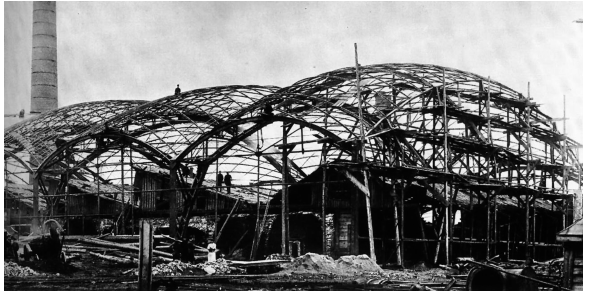
Figure 5: Production Hall in Vyksa, Rusia by V. Shukhov. Source: